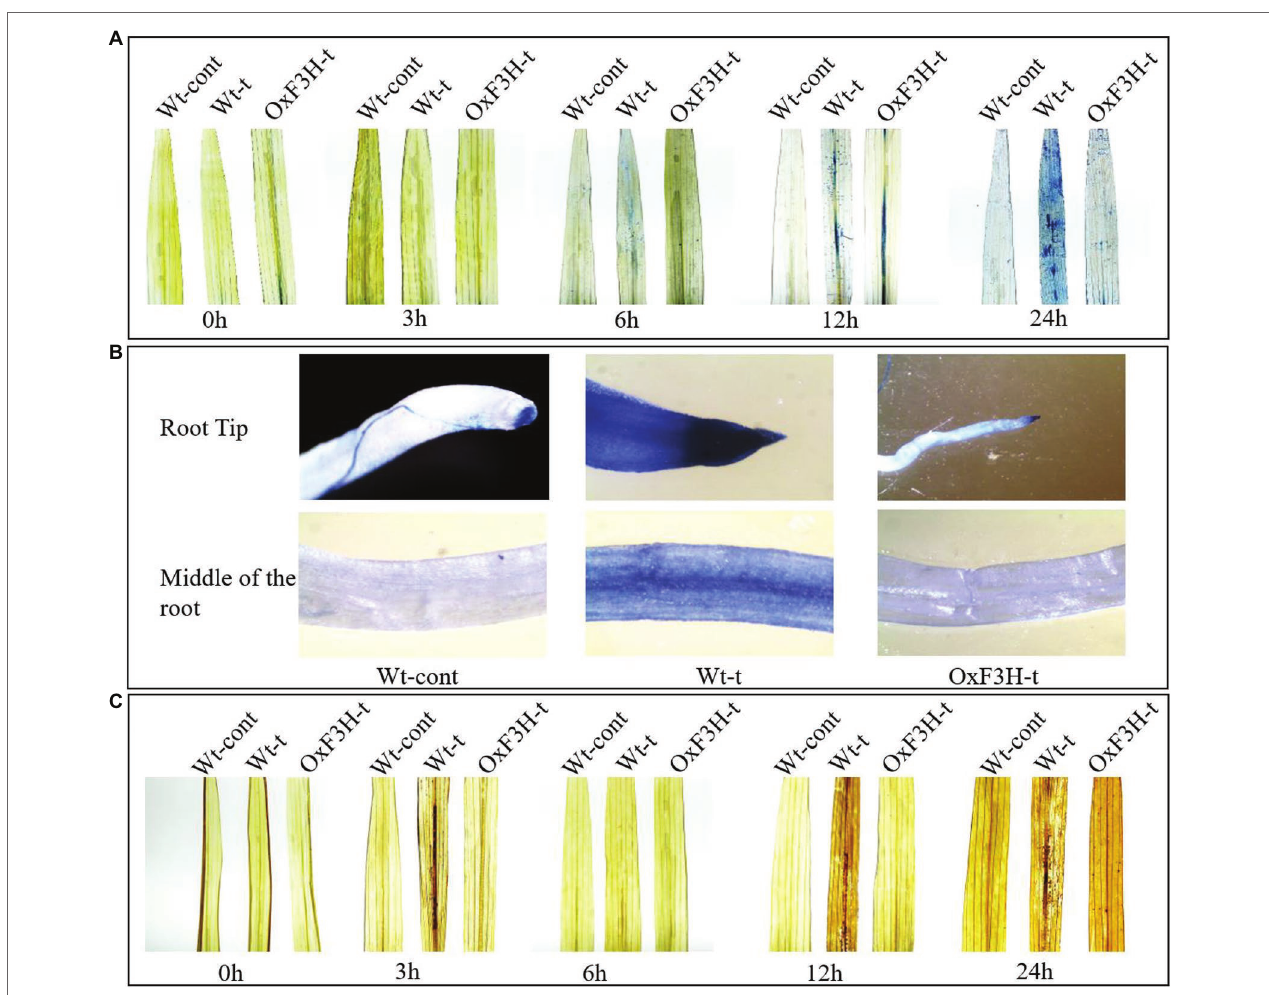
FIGURE 3 | Combined salt and heat stress causes severe oxidative stress in leaves and roots. (A,B) Cell death in leaves and roots, respectively, according to Trypan blue staining. (A) indicates that substantial cell death occurred in the leaves of Wt-t plants after 12 and 24 h of stress exposure. (C) H 2 O 2 generation in the leaves of Wt-cont, Wt-t, and OxF3H-t plants as detected using DAB staining. Wt-t leaves showed high concentrations of H 2 O 2 after 12 and 24 h of stress